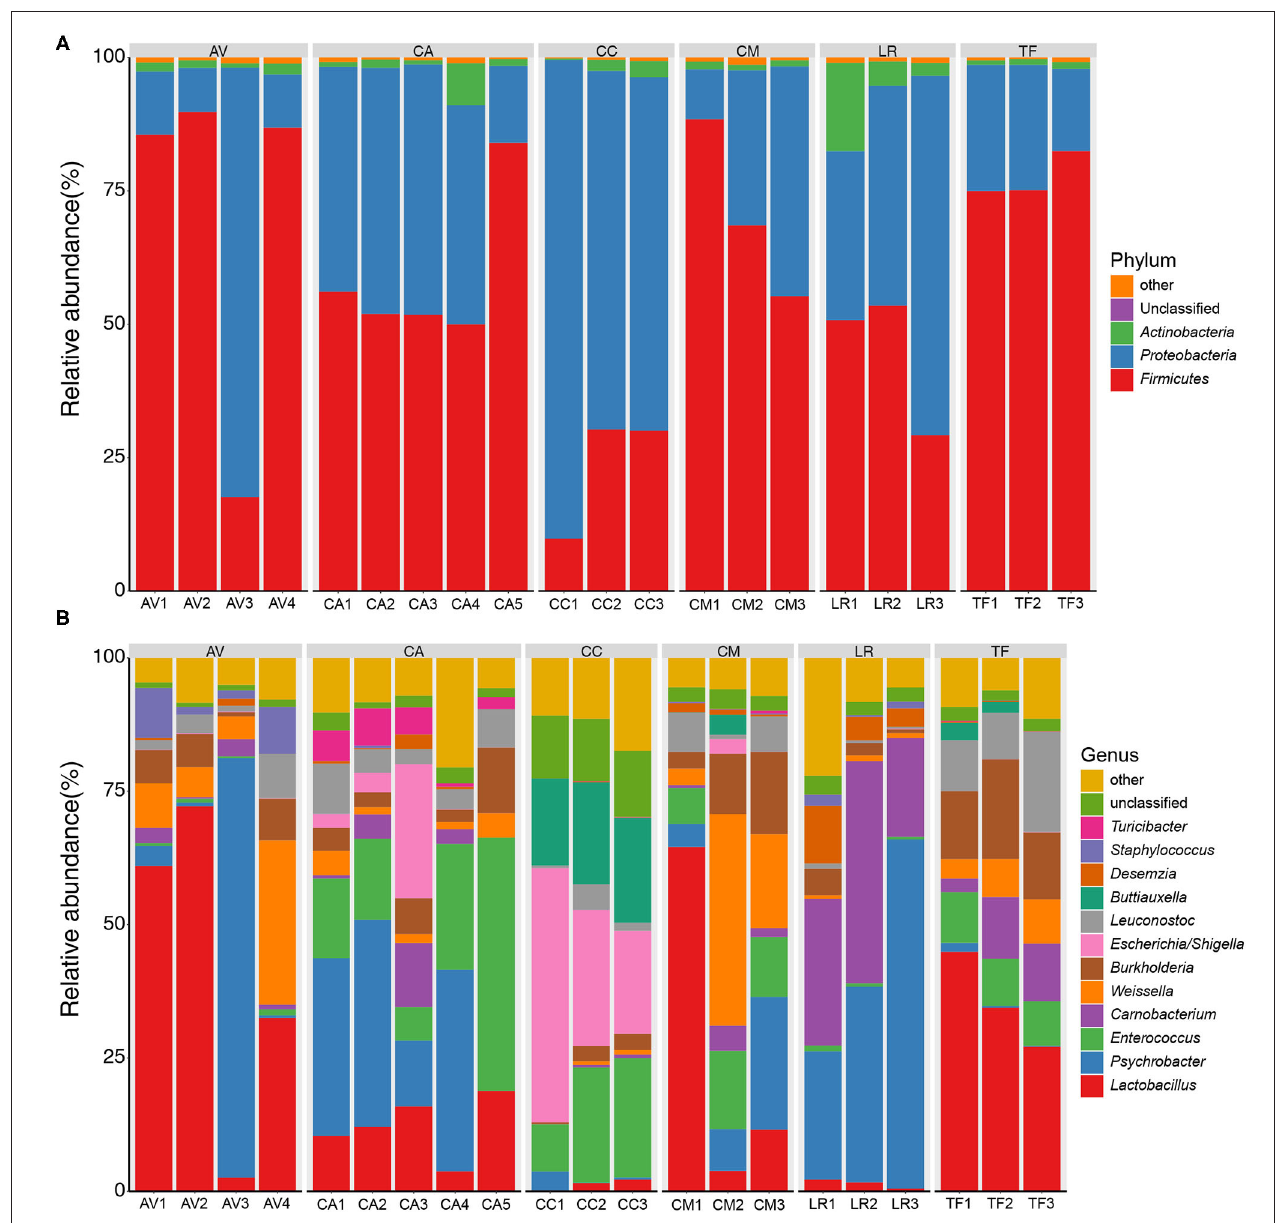
FIGURE 3 | Bar chart of relative bacterial abundance at phylum (A) and genus (B) level. Bacterial phyla and genus with relative abundance (%) over 1% are shown. Others, bacterial taxa with a relative abundance of ≤ 1%. AV, demoiselle crane ( Anthropoides virgo ); CA, black swan ( Cygnus atratus ); CC, whooper swan (